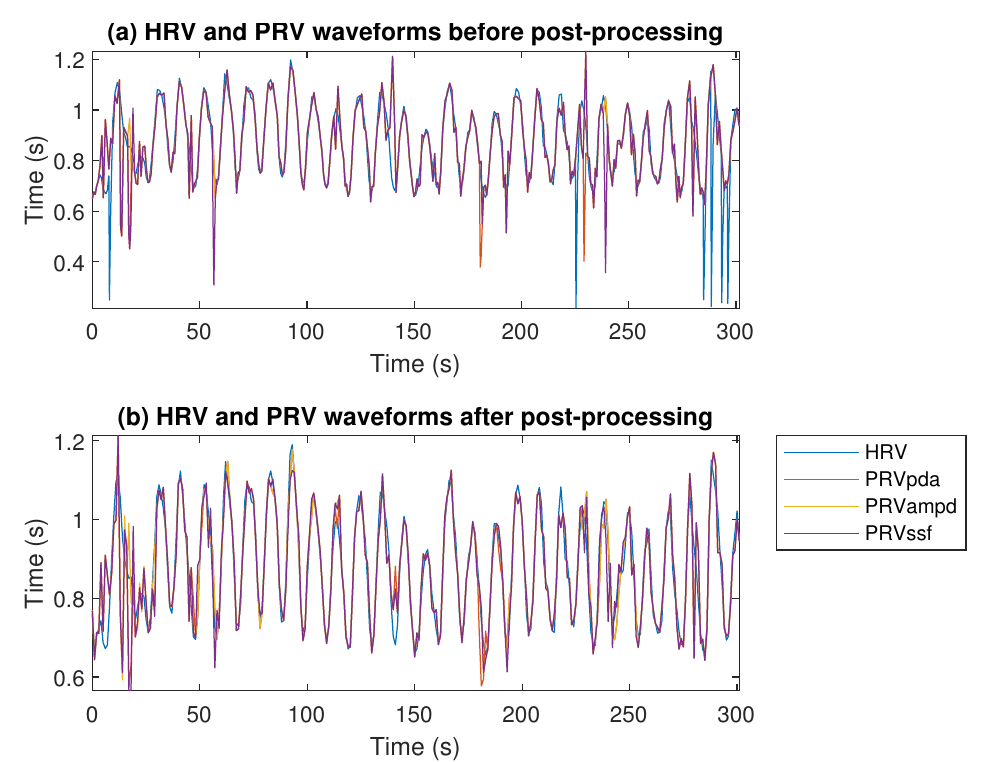
Figure 6. Comparison of the HRV and PRV waveforms for each algorithm before ( a ) and after ( b ) post-processing. The Arm experiment, person P6.